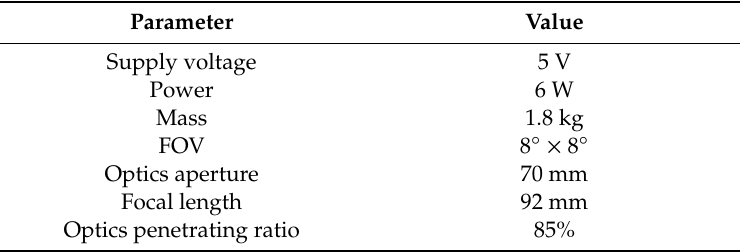
Table 3. Parameters of the All-Time star sensor.